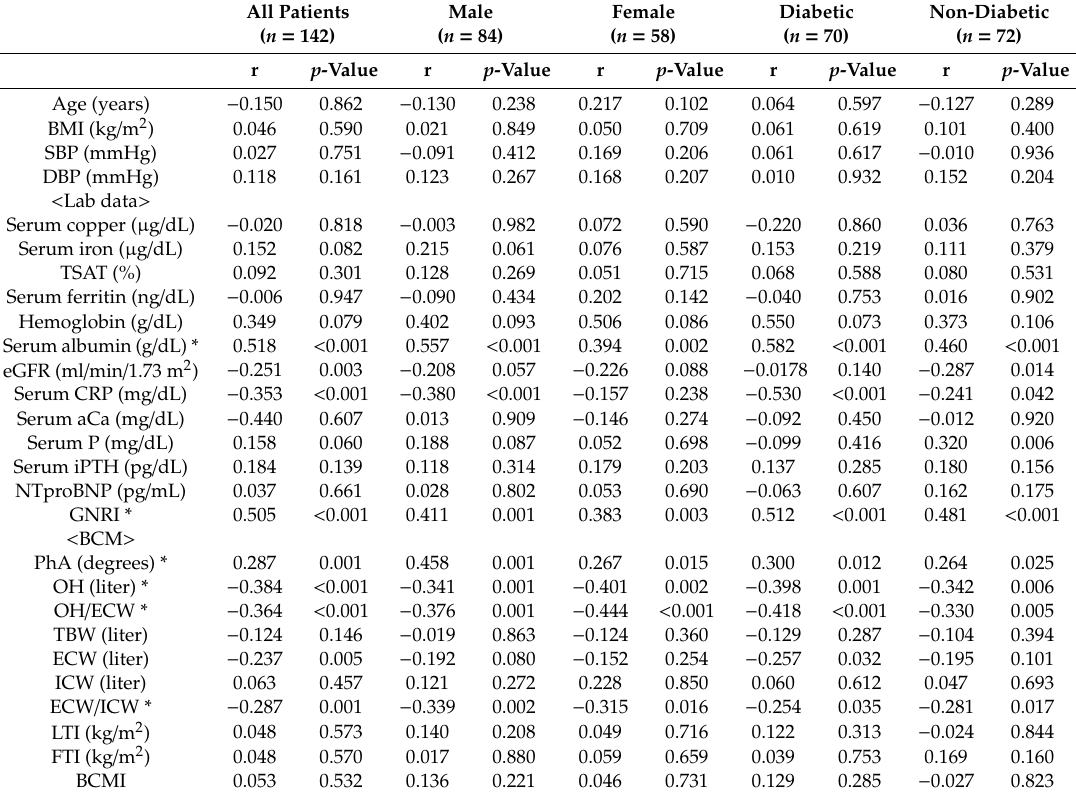
Table 2. Correlation analyses of serum zinc and clinical parameters.